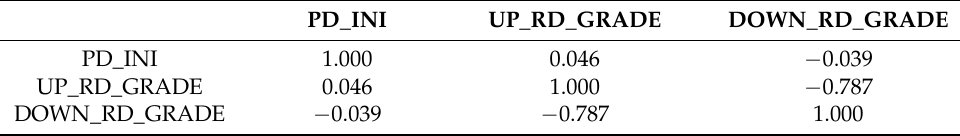
Figure 6. Correlation Coefficient Matrix of Dependent variables and Numerical Variables. ( a ) Correlation coefficients of distress initiation and geometric data, meteorological data without time lag. ( b ) Correlation coefficients of distress initiation and geometric data, meteorological data with time lag. Table 2. Correlation Coefficients Matrix of Dependent Variable and Categorical